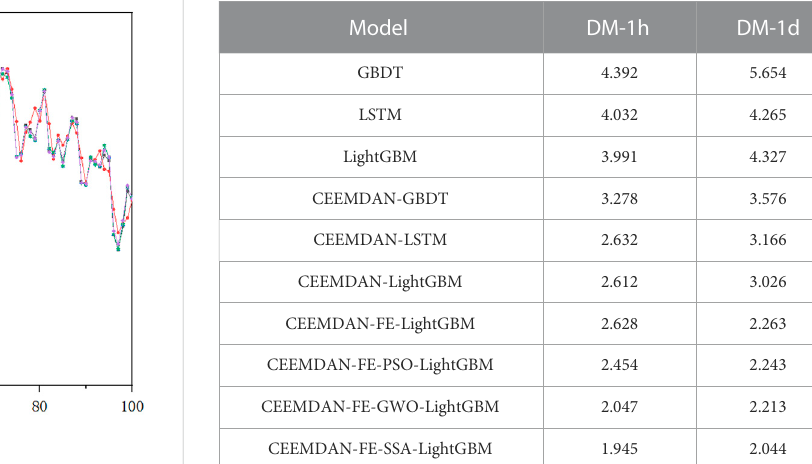
FIGURE 16 Case 2 graph of this paper ’ s model versus the hybrid model.